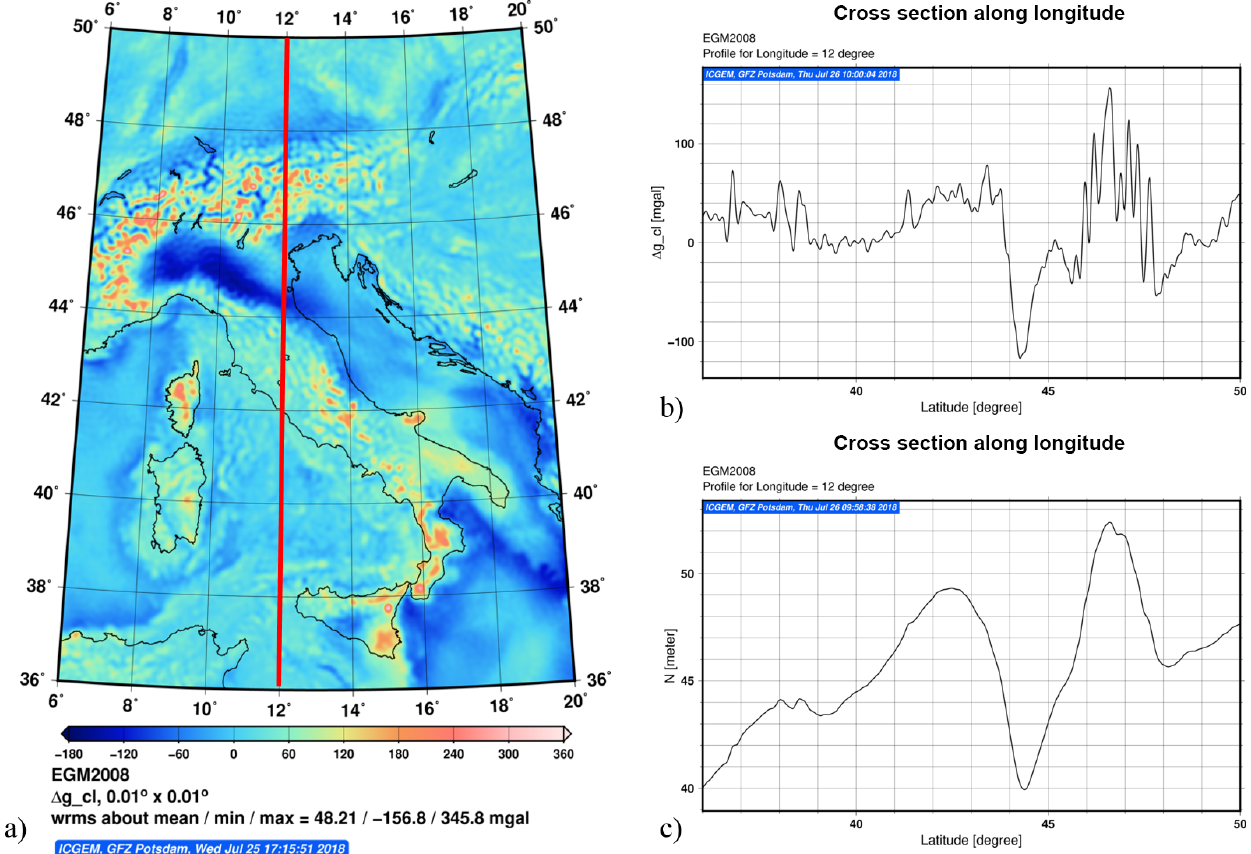
Figure A3. Cross section calculation of the gravity field functionals along longitude. The figures below show (a) classical gravity anomalies at grid points where the red line indicated the cross section along longitude, (b) cross section classical gravity anomalies along longitude, and (c) cross section geoid undulations along longitude.